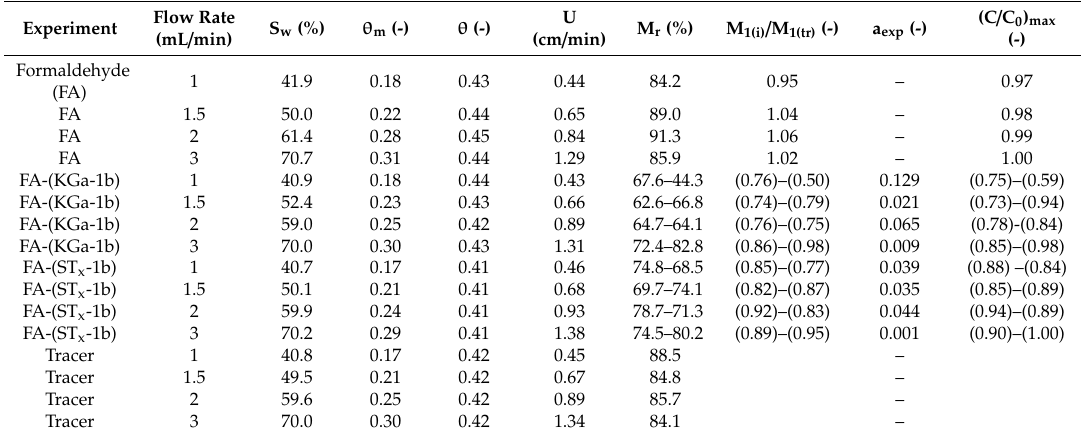
Table 2. Experimental conditions and results.